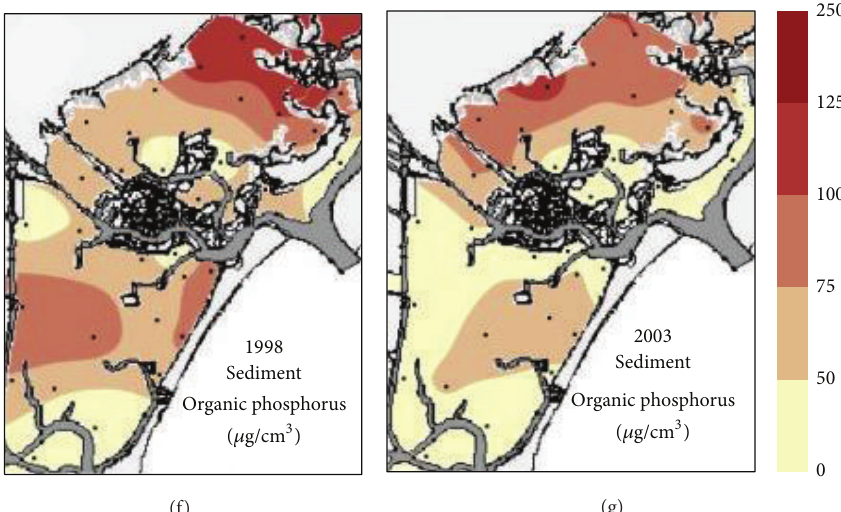
Figure 5: Spatial distribution of phosphorus concentrations in 2003: total phosphorus (a), inorganic phosphorus (b), and organic phosphorus (c). Mean values and standard deviations shown on maps for whole lagoon (W) and northern (N), central (C) and southern (S) basins. Other maps indicate distributions in 1987 (d), 1993 (e), 1998 (f), and 2003 (g) in central